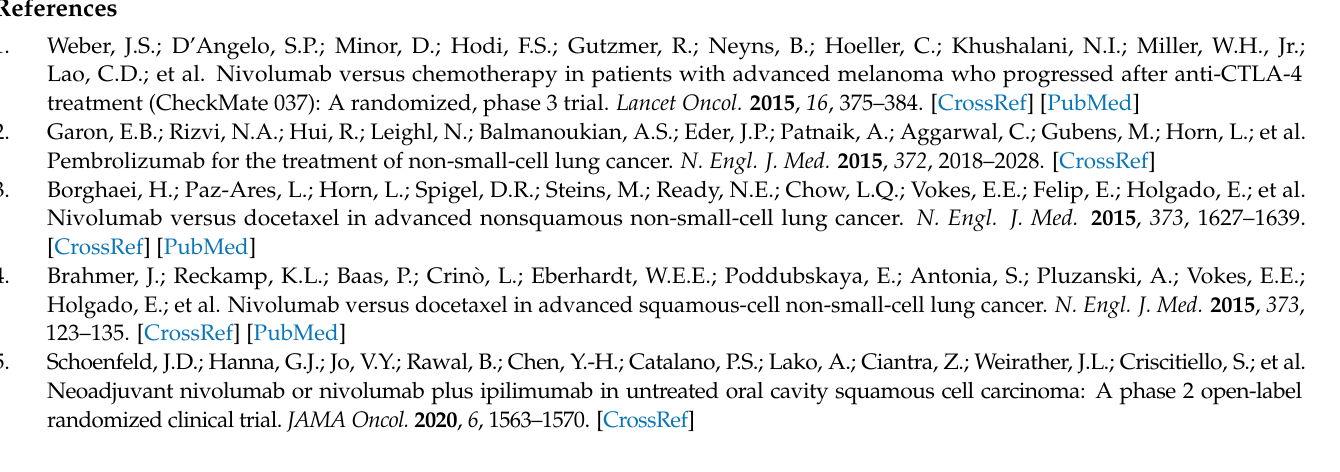
(TIME) classification of human colorectal cancer (CRC) specimens using CD8 immunostaining; Figure S2: Effect of dasatinib on cancer-associated fibroblasts (CAF) and CT26 cell proliferation; Figure S3: Body weight chart of mice in each treatment and control group; Table S1: Clinicopathological features and phenotype classification of study participants and resected col-orectal cancer (CRC) specimens (n =